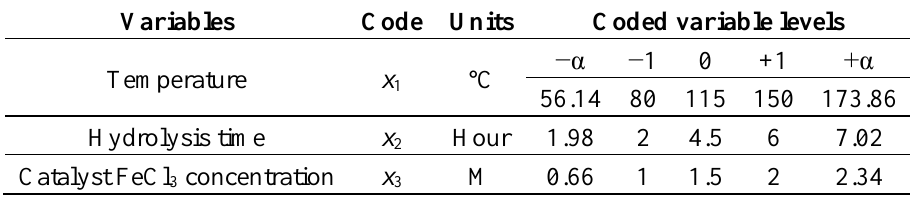
Table 7. Independent variables for acid hydrolysis with their actual and coded